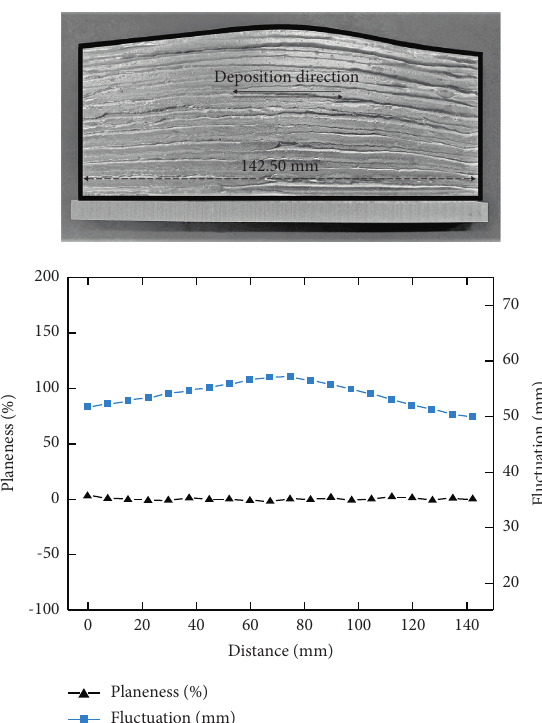
Figure 7: Side flatness and top surface volatility of the deposition wall with the copper plates constrained path.